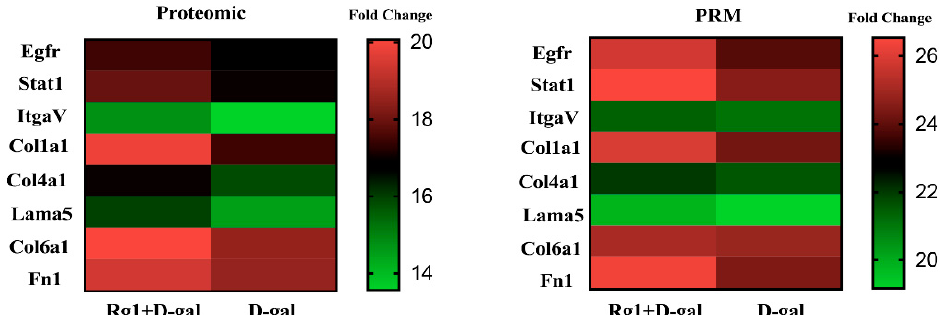
Figure 8. The relative fold change of the eight proteins in D-gal + Rg1: D-gal by 4D-label free proteomics and PRM. (each sample consists of the liver tissue of 5 mice).